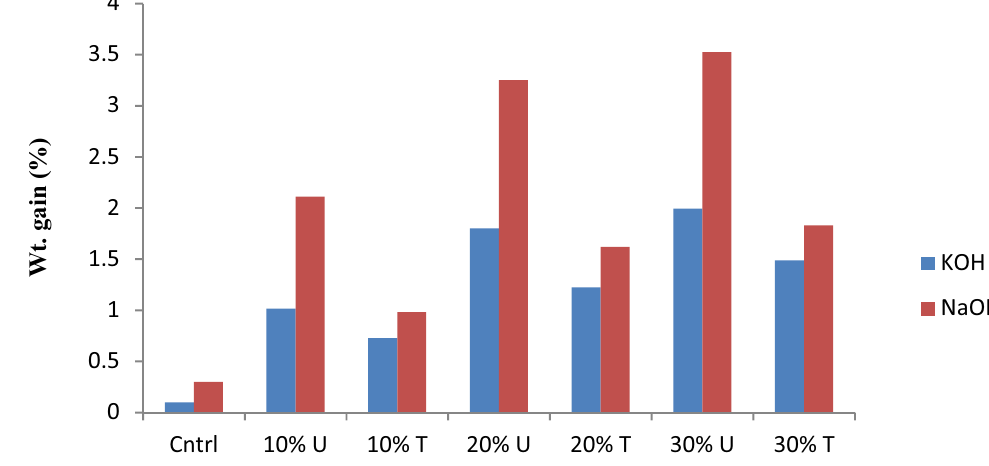
Figure 3. Base chemical resistance test of the